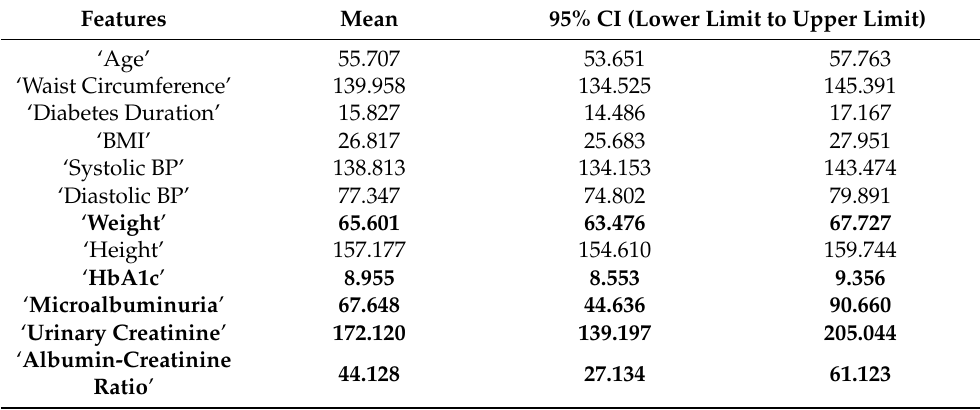
Figure 5. ( a ) Chi-squared test result. The importance of different marked features was used in the model as an identifier; ( b ) confusion matrix of the RET test (pClass vs. nClass); ( c ) performance evaluation matrices; ( d ) TPR vs. FPR, graphical view of the RET classifier model performance. Table 8. 95% confidence interval for diabetic retinopathy patients (categorical features, such as gender, smoking history, and smokeless tobacco history, have been omited from the table). The subject count is 96 (7 pRet and 89 nRet patients) and the features that are used in the model classifier are marked in bold